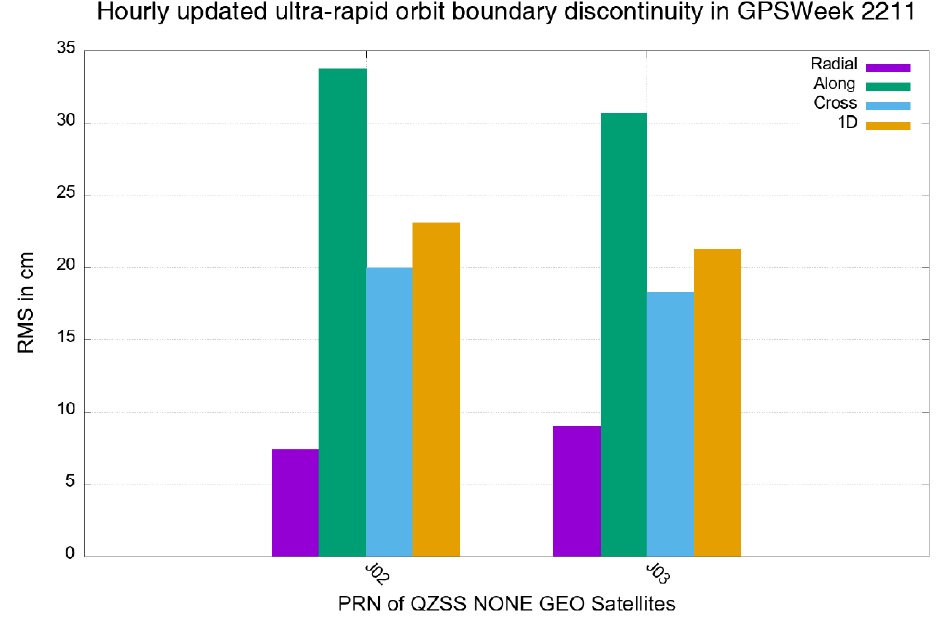
Figure 19. Mean RMS of overlapping in the RAC components and 1-D of QZSS NONE GEO satellites.